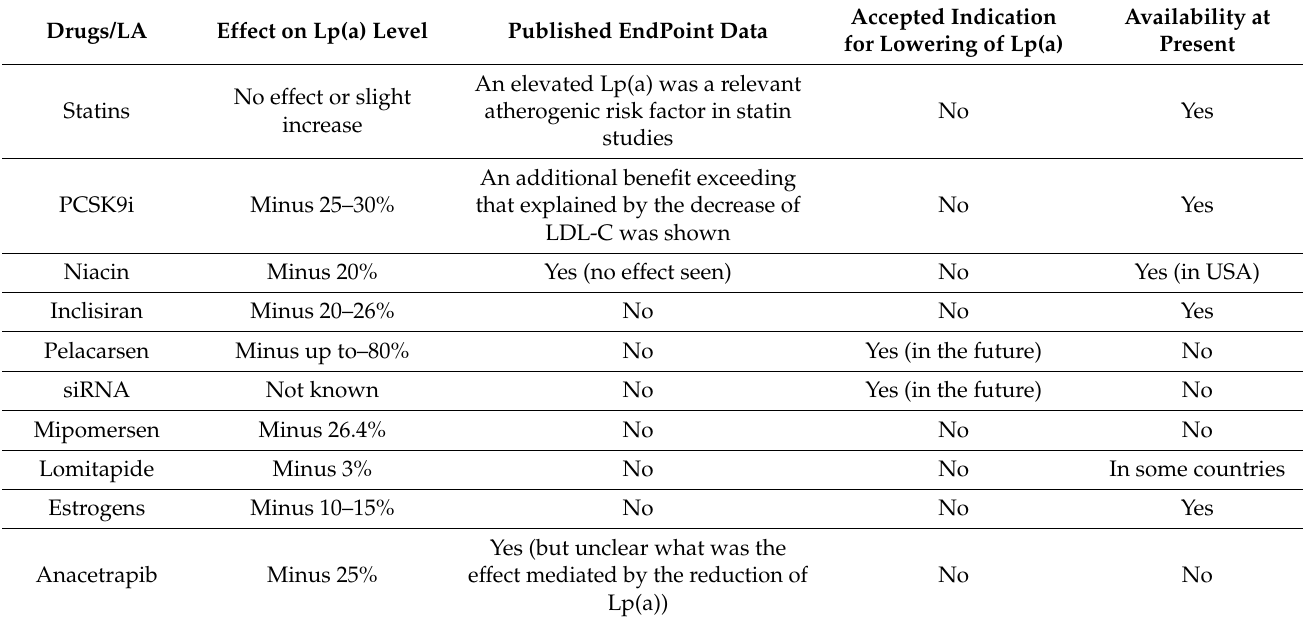
Table 2. Drugs and Lipoprotein apheresis (LA)—effects on Lp(a) levels, published outcome data, accepted indication for lowering Lp(a), current